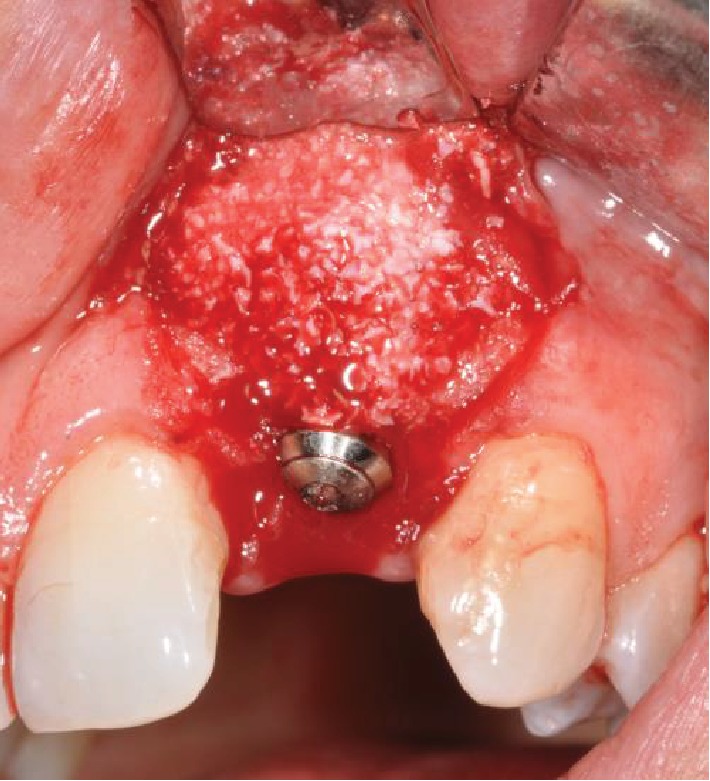
Tissue regeneration.